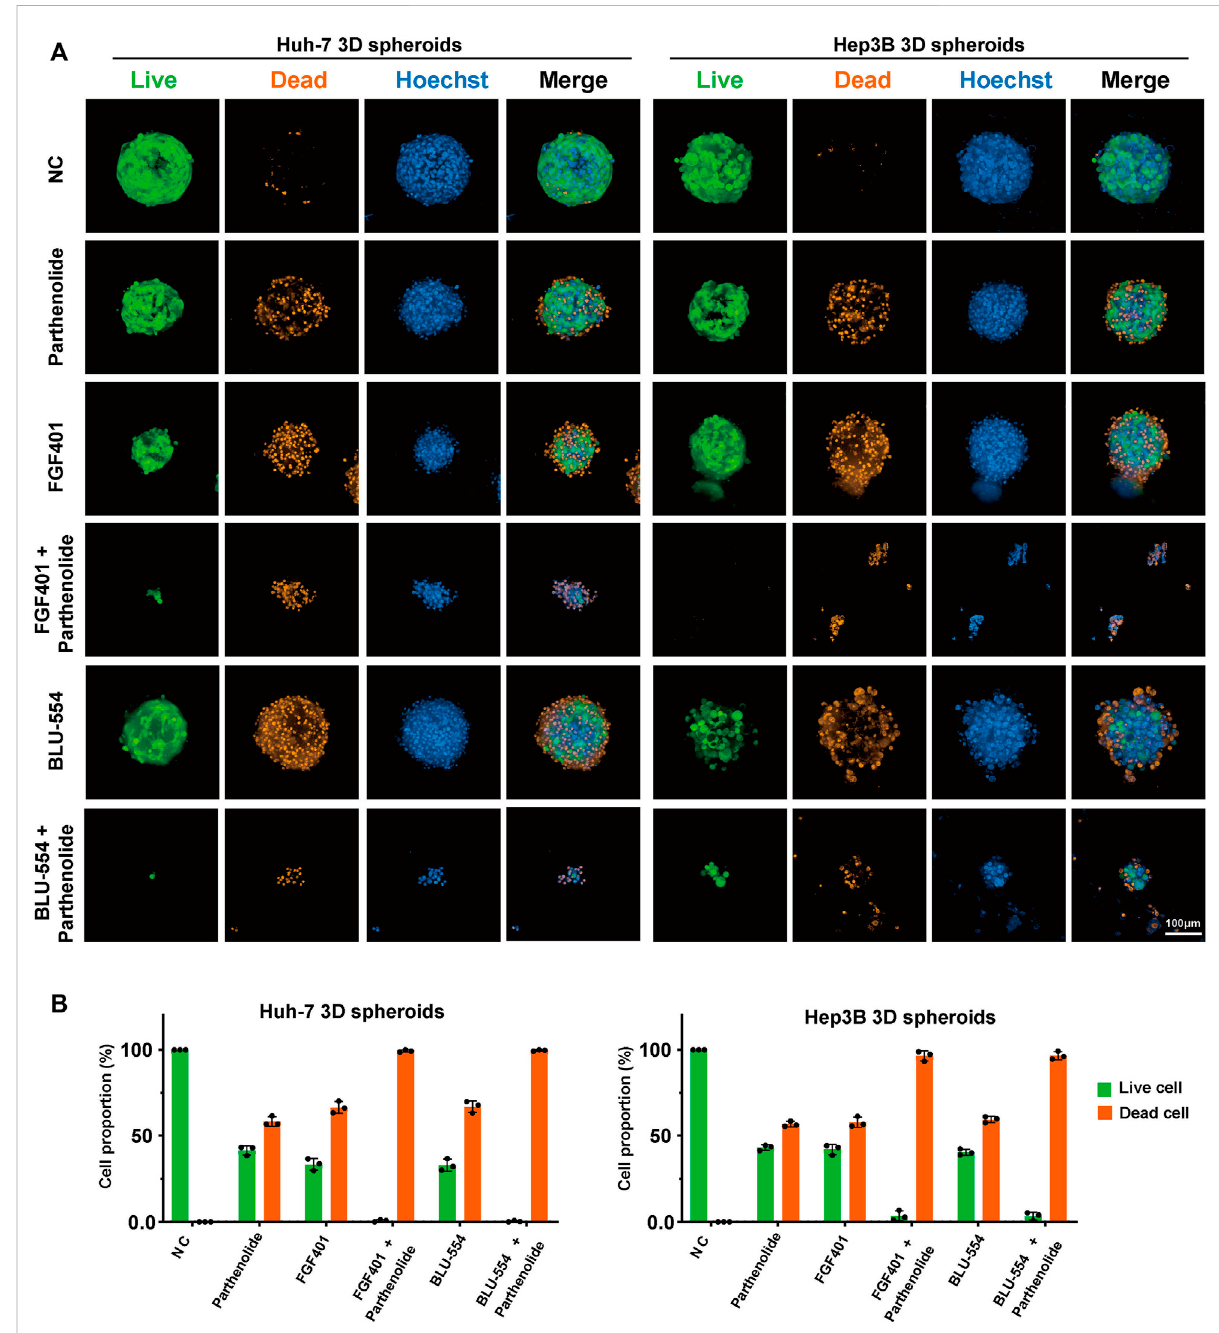
FIGURE 6 3D cell spheroids to evaluate the effect of combined application of FGFR4 inhibitors and Parthenolide. (A) The Live/dead probe staining was usedtodetectthelivingordeadlevelsof3Dcellspheroidsusingthecombinationdrugschemes. (B) TheLive/deadprobestainingwasusedtodetect the living or dead levels of 3D cell spheroids using the combination of drug